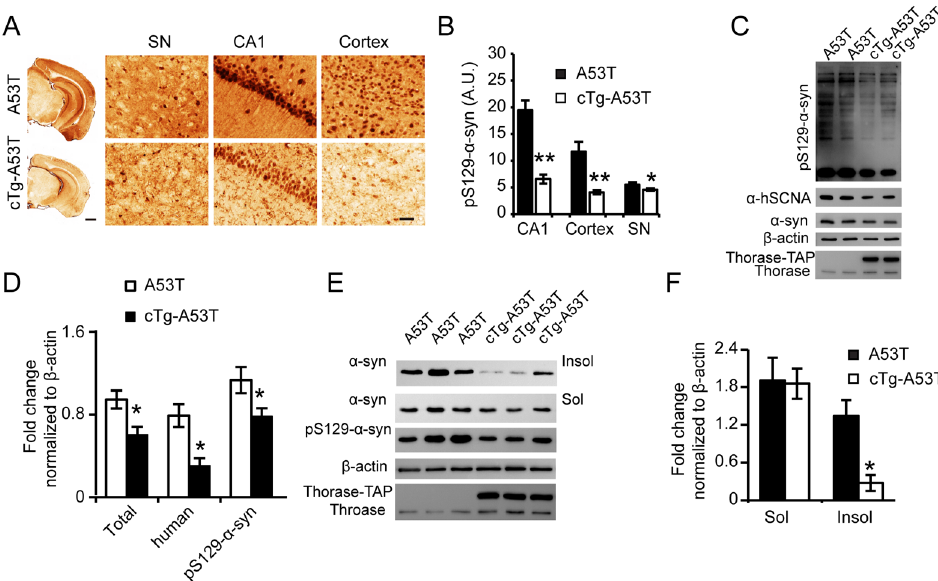
Figure 6. Thorase overexpression prevents α -synucleinopathy in PD mouse model A53T mice. ( A ) Representative images of immunohistochemical staining for pS129- α -syn in the SNpc, hippocampus, and cortex in sections from Thorase-TAP-hA53T α -syn (cTg-A53T) and A53T littermate mice at the age of 9 months. Scale bars, 1 mm for low magnification and 15 μ m for high magnification images. Anti- α -syn (phospho S129) antibody (Abcam, 1:1000). ( B ) Quantification of the immunohistochemical staining of pS129- α -syn in the hippocampus, cortex, and SNpc. ( C ) Western blot assay of pS129- α -syn in the brains of Thorase cTg-A53T and age-matched A53T littermate mice. Anti- α -syn (phospho S129) antibody (Abcam, 1:1000); anti- α -syn antibody (BD, 1:1000); anti- α -syn antibody (Abcam, 1:1000). ( D ) Quantification of pS129- α -syn levels in panel ( C ) with normalization to β -actin (n = 5). ( E ) Western blot assay of insoluble α -syn, soluble α -syn, and pS129- α -syn in the brains of Thorase cTg-A53T (n = 6) and A53T littermate mice (n = 5). Anti- α -syn (phospho S129) antibody (Abcam, 1:1000); anti- α -syn antibody (BD, 1:1000). ( F ) Quantification of the Western blot data shown in panel ( E ). Data are presented as the mean ± SEM, determined by unpaired two-tailed Student’s t-test. * p < 0.05, ** p < 0.01.